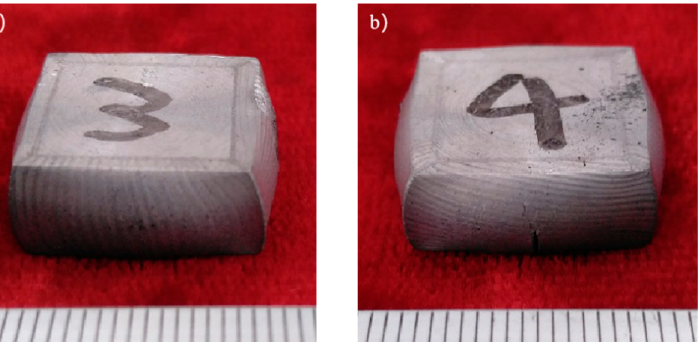
Figure 4. The samples morphology of the aluminum matrix composite: ( a ) Compression deformation amount of 46%; ( b ) Compression deformation amount of 50%.